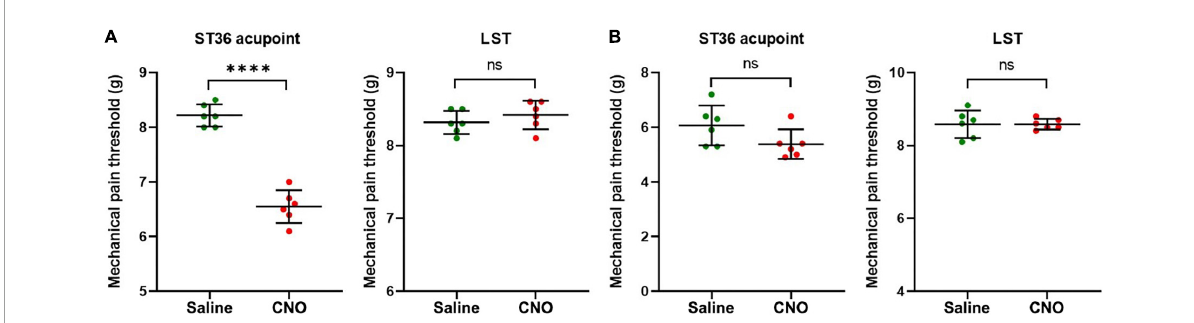
FIGURE6 Activation of shared neurons declined the mechanical pain threshold of ST36 acupoint. (A) The CNO treatment decreased the mechanical pain thresholds of the ipsilateral ST36 acupoint but not the LST in the normal mice. n = 6, paired t -test. For ST36 acupoint, ∗∗∗∗ P < 0.0001. For LST, P = 0.4466. LST, the position 5 mm lateral side of the ST36. (B) The CNO treatment did not significantly change the mechanical pain thresholds of the ipsilateral ST36 acupoint and the LST in the CFA model. n = 6, paired t -test. For ST36 acupoint, P = 0.1849. For LST, P >